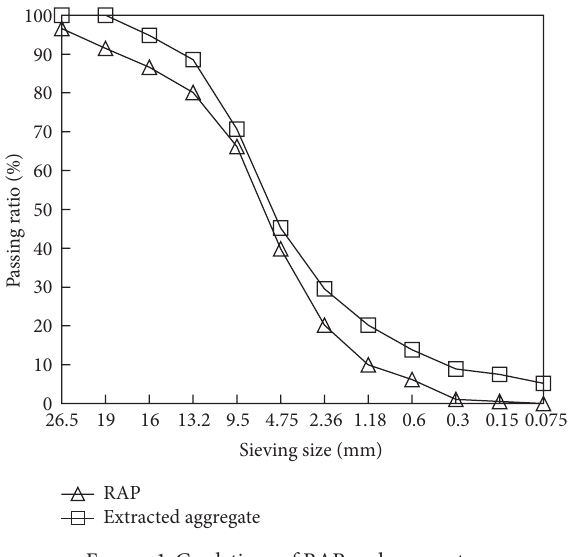
Figure 1: Gradations of RAP and aggregates.